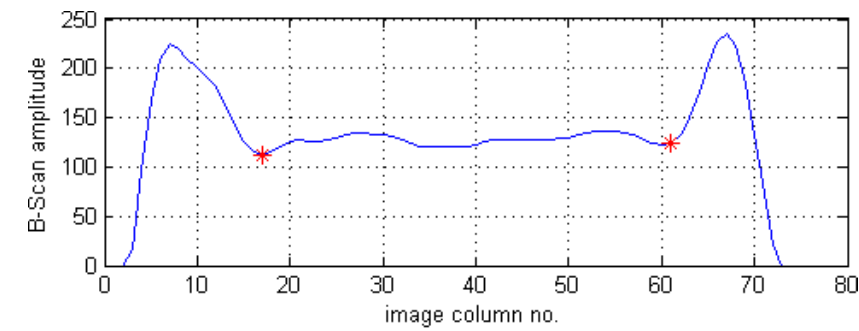
Figure 7. Amplitude values of an exemplary row of a B-Scan and detected minima.